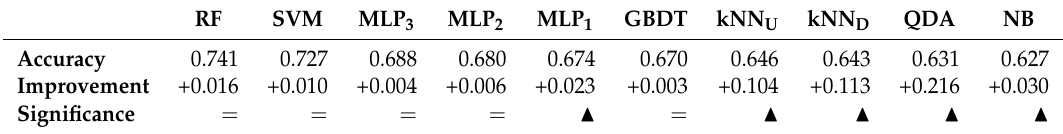
Table 5. Average accuracy scores for the experiment with features